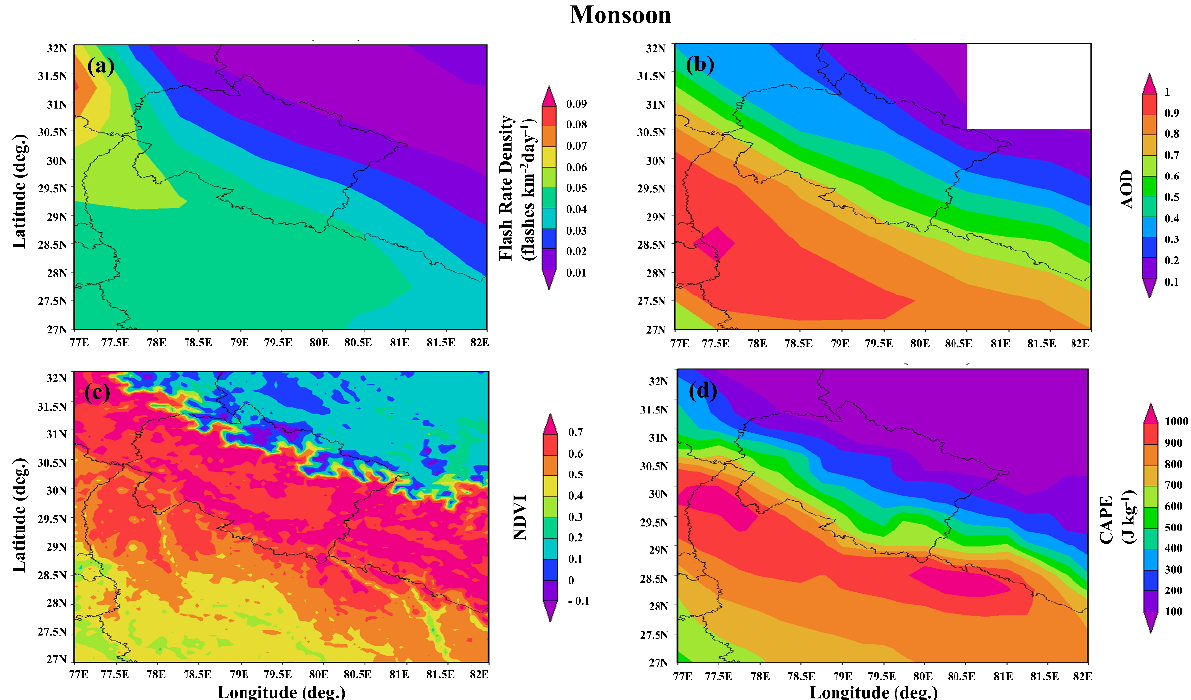
Figure 5. Spatial distribution of ( a ) LFRD, ( b ) AOD, ( c ) NDVI, and ( d ) CAPE for monsoon season over the study region.